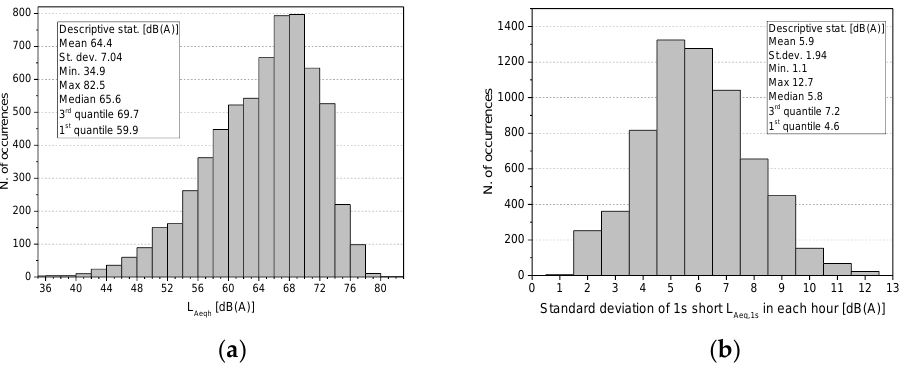
Figure 3. The distribution of ( a) the 6426 hourly L Aeq,1h considered in the study; ( b ) the standard deviation σ 1h of 1 s short L Aeq,1s in each hour.